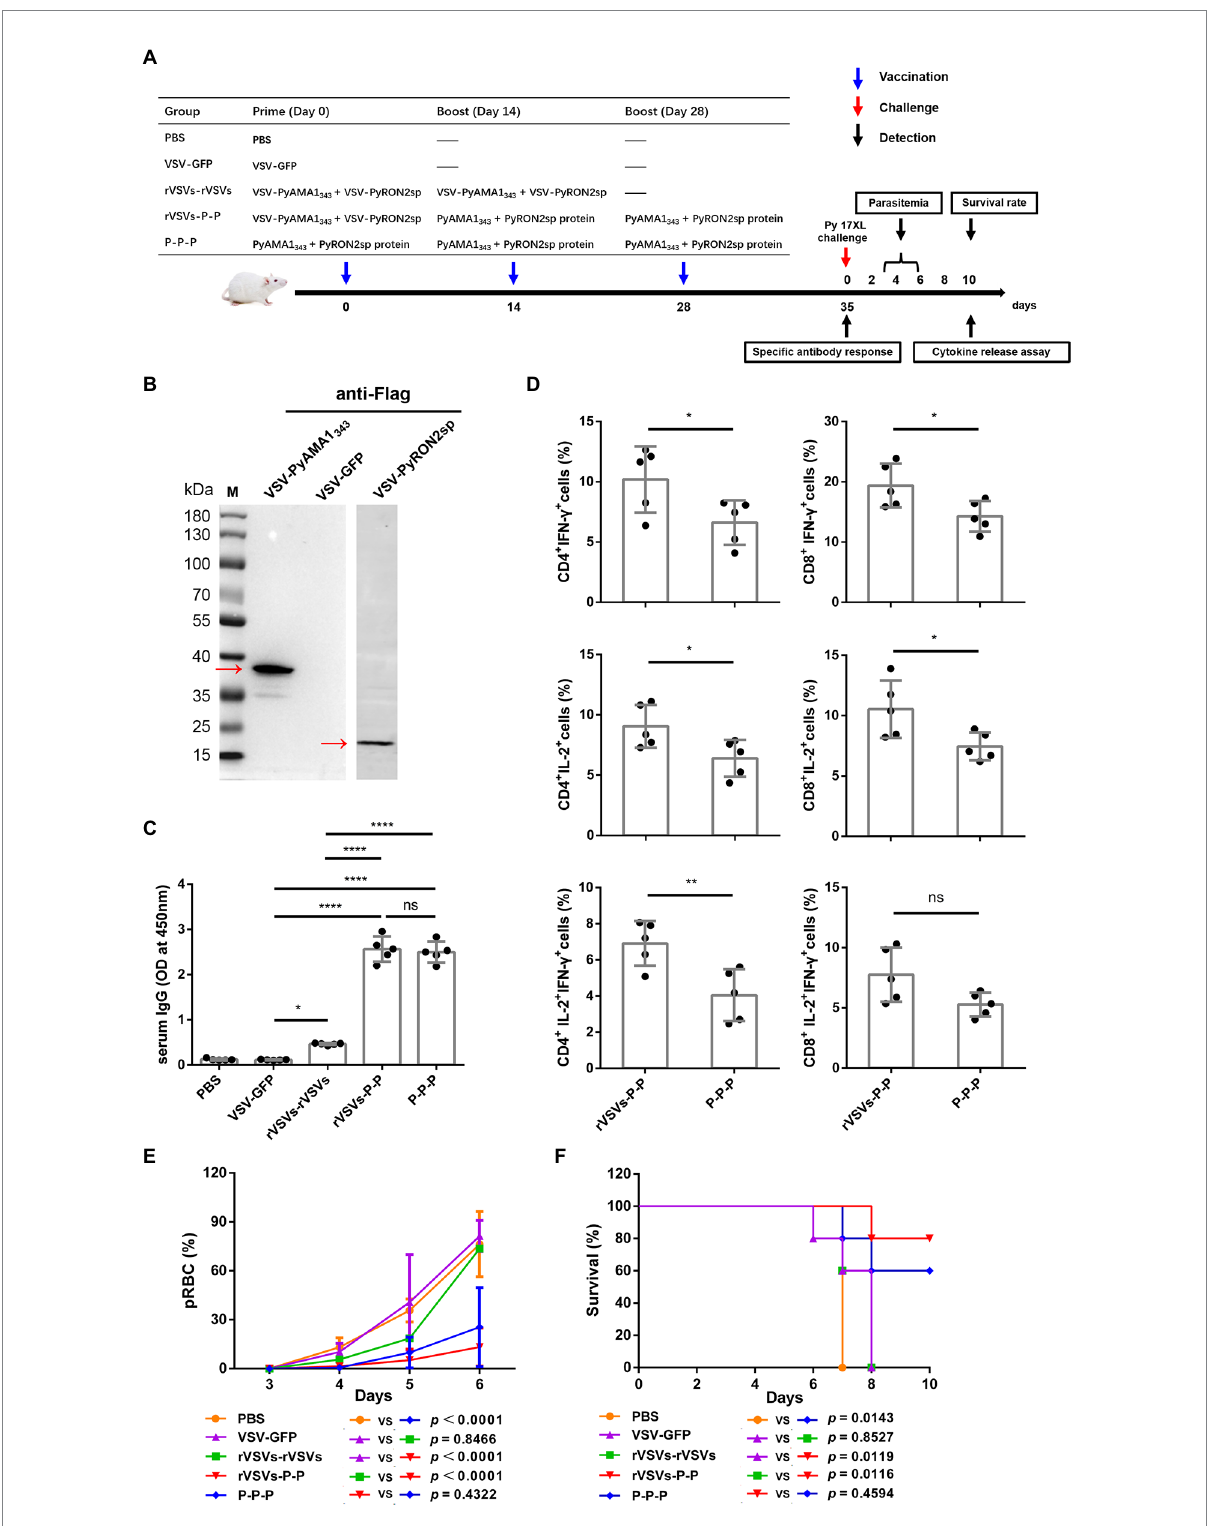
FIGURE 6 Antigen-specific immune response and immune protection induced by rVSVs. (A) The workflow of vaccination, challenge, and detection procedure. BALB/c mice ( n = 5 per group) were intranasally immunized with 25 μ l of 10 6 PFU VSV-PyAMA1 343 + VSV-PyRON2sp (VSV-PyAMA1 343 and VSV-PyRON2sp mixture) through prime-boost vaccination. The mice were intraperitoneally injected with 50 μ g PyAMA1 345 + PyRON2sp antigens three times at the indicated time points. Mice were infected with Py17XL with 5 × 10 5 perythrocytes 35 days after first immunization. Immune responses were detected at the indicated time points. (B) Western blot analysis of expression of PyAMA1 343 and PyRON2sp in BSR-T7 cells that